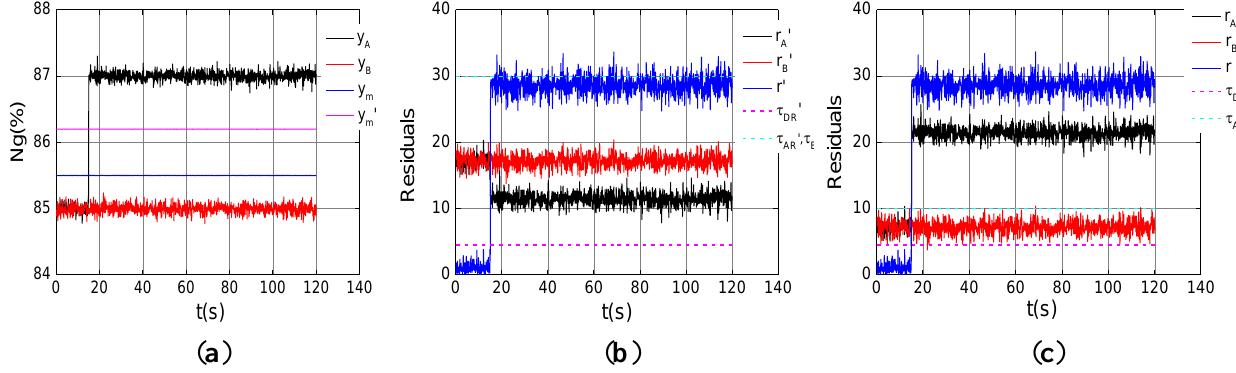
step fault under the steady state of ng % = 85%. g